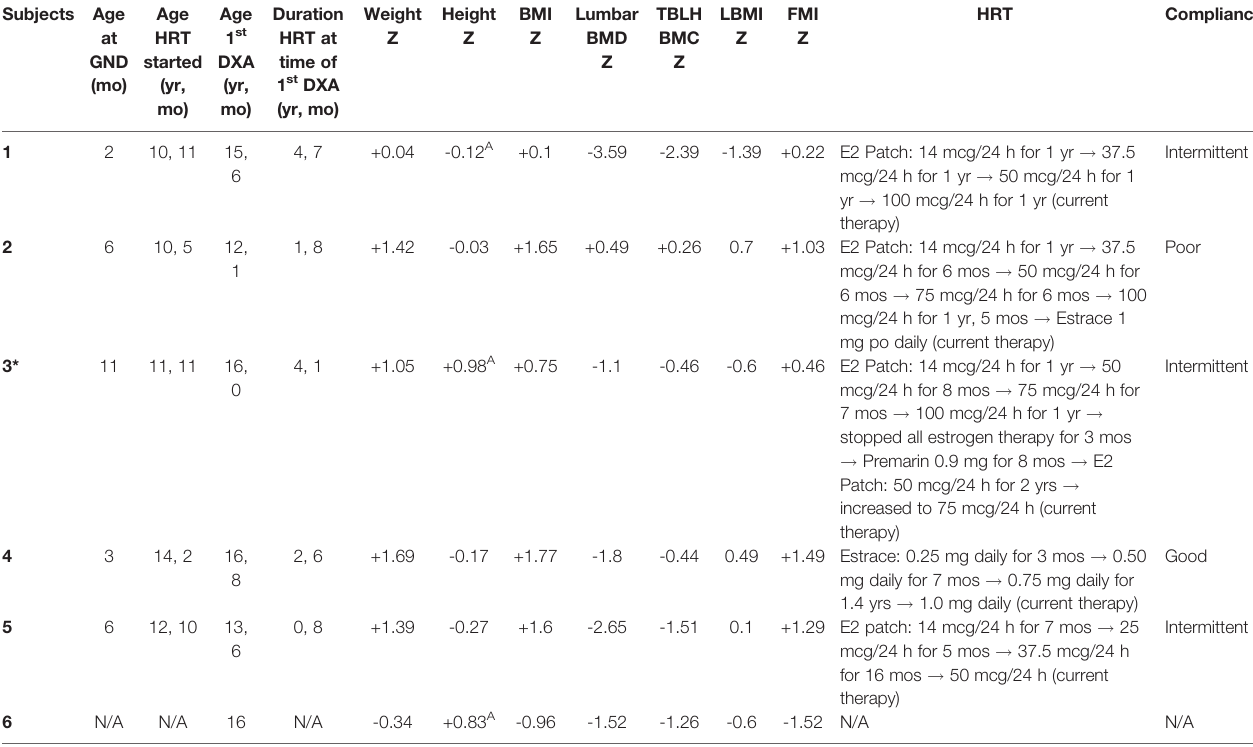
TABLE 1 | Baseline characteristics, type/timing of HRT, and results of fi rst DXA scans for all six cases. Subjects Age